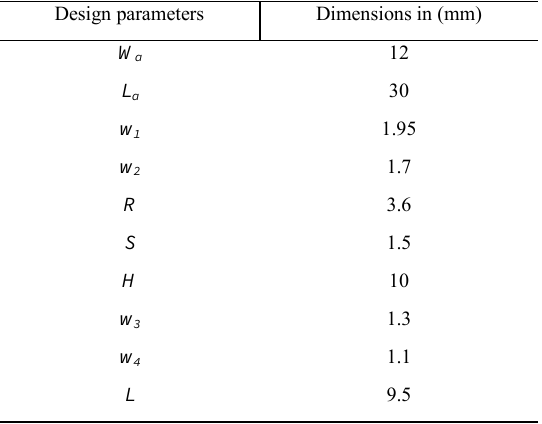
Figure3: Simulated reflection coefficient for various length of DRA